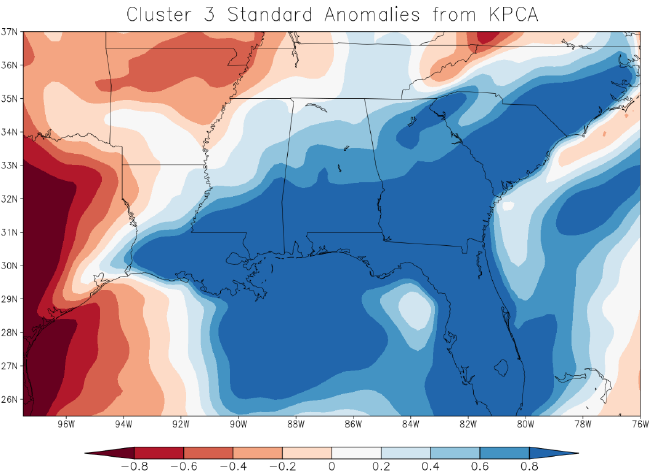
Figure 8. Cluster 3′ s 15-day precipitation standard anomalies derived from KPCA-preprocessed Figure 8. Cluster 3 (cid:48) s 15-day precipitation standard anomalies derived from KPCA-preprocessed cluster analysis. This pattern matched the cluster analysis with no KPCA-preprocessing. cluster analysis. This pattern matched the cluster analysis with no Overall, the clusters showed strong similarities in terms of the dominant spatial fea- tures. All clusters showed the driest conditions in the western portions of the SEUS study domain, which resulted from the influence of more abundant drier conditions from the desert southwest and its continental tropical air mass. All patterns also showed the abun- dant coastal precipitation observed in the mean field, as well as relatively reduced precip- itation in the southern Appalachians (with the notable exception of the small precipitation